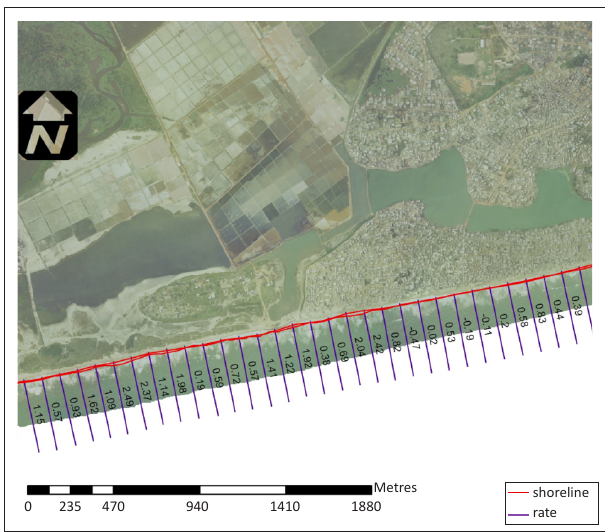
FIGURE 12: Mapped shoreline position along the Gleefe